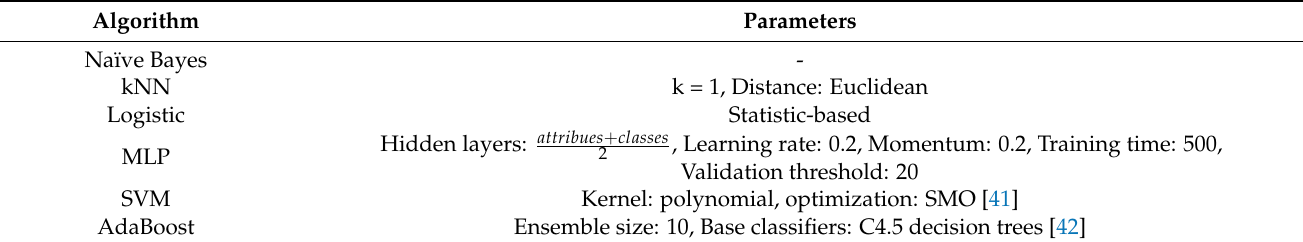
Table 4. Parameters of the algorithms against which the D1-NN classifier is compared. Algorithm Parameters Naïve